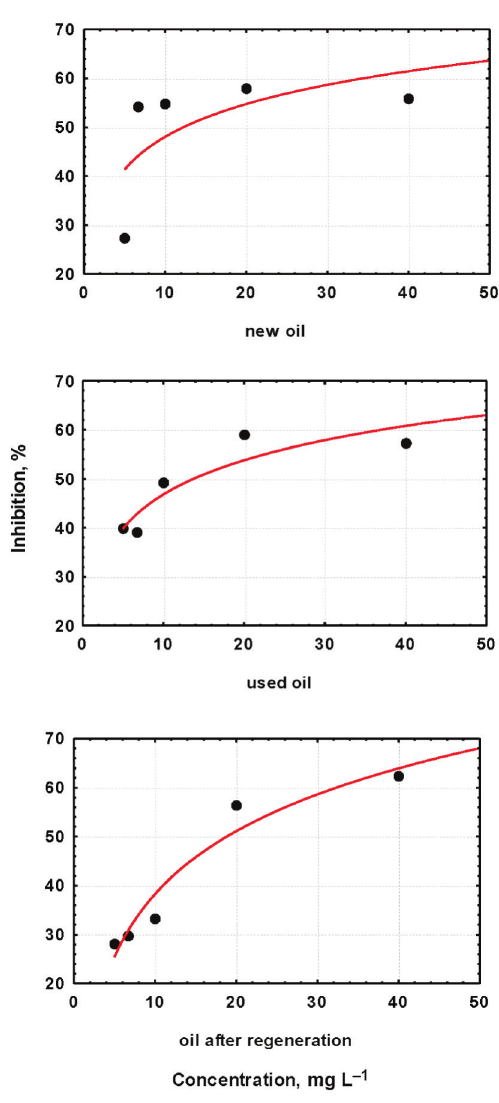
Fig. 6 – Plot of biodegradability with time in the oil samples